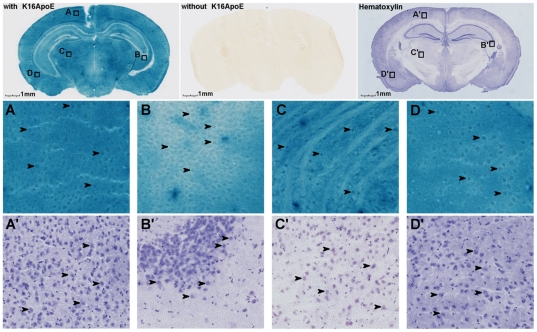
Delivery of beta-galactosidase in mouse brain through K16ApoE and visualization of cells stained for beta-galactosidase activity in different areas in the brain following delivery of the enzyme.Beta-galactosidase (one nanomole) was injected in mice mixed with K16ApoE (70 nanomoles), tissue slices made six hours after injection were stained for enzyme activity (top left). Middle image, top row –an image of a brain slice obtained after delivering beta-galactosidase without K16ApoE. Third image, top row – image of a brain slice stained with hematoxylin. Also, high magnification (20×) images from four regions of the beta-galactosidase-stained section (A,B, C and D) and hematoxylin-stained comparable regions (A′, B′, C′ and D′) are shown. A,A′ - retrosplenial agranular cortex; B,B′ - CA3 field, hippocampus; C,C′ - posterior thalamic nuclear group; D, D′ - basolateral amygdaloid nuclei, posterior. Arrows indicate some of the cells in the respective regions.